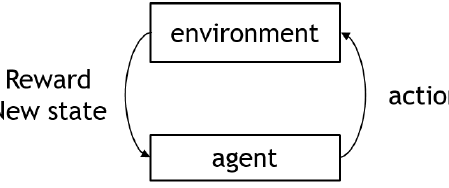
Figure 2. Block diagram of typical